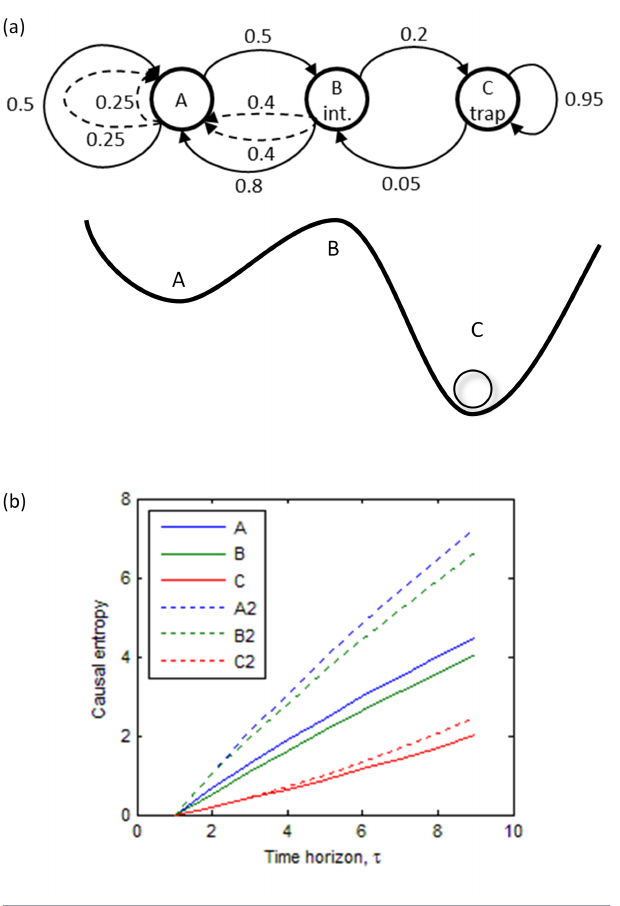
Fig. 4. Pathway diversity of a poverty trap. (A) State-and- transition model showing a state A, which recovers from a transition to state B with high probability (0.8), but if a transition to C occurs, then recovery is highly unlikely (0.05). The intention, as illustrated in the ball-and-cup diagram, is that C corresponds to a trapped state of high persistence; A is a more desirable stable state with lower persistence, and B is an unstable intermediate state. (B) Causal entropy for the different states as a function of the time horizon. A is the state of highest causal entropy, followed by B, then the trapped state C. Where there are two recovery paths from B to A as well as two paths to maintain A, the causal entropy of states A and B are even higher (dotted lines, A2–C2 in figure